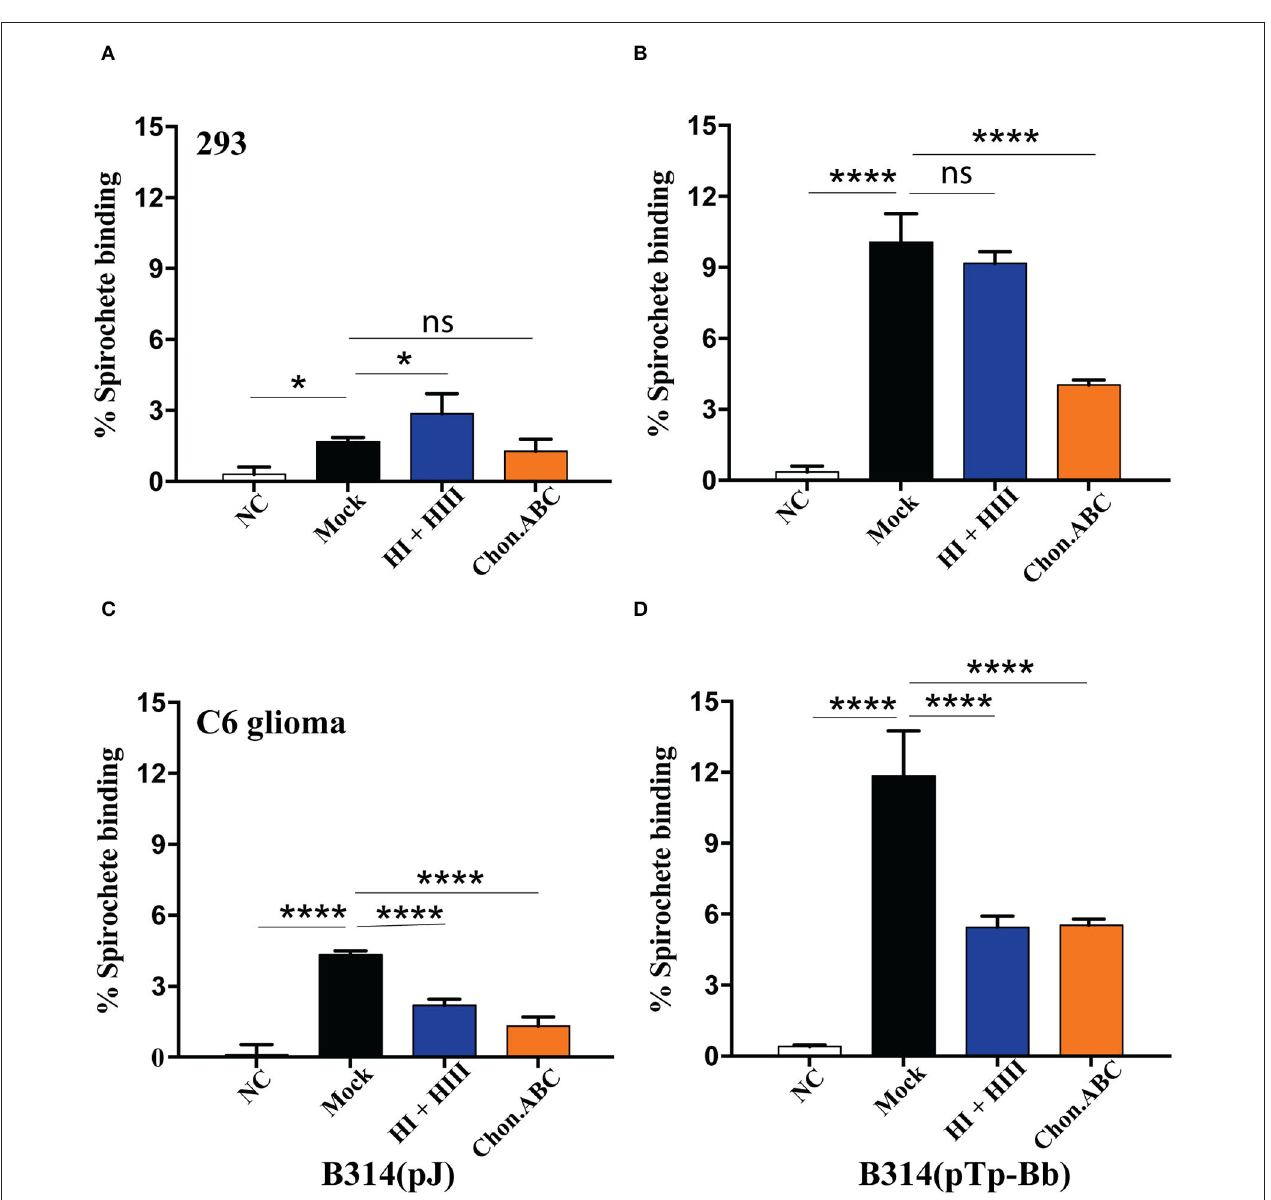
FIGURE 4 | Heparan sulfate and dermatan sulfate as ECM components on specific mammalian cells are required for Tp0954-expressing spirochetes binding. (A,C) Low level binding of B314(V) strain were observed to both 293 and C6 glioma cells and removal of GAGs by specific lyases reduced binding further. (B) Pretreatment of 293 with chondroitinase ABC and not by a combination of heparinase I and III (HI and HIII) inhibited binding of radiolabeled Tp0954-expressing B314 strain, indicating contribution of dermatan sulfate to adherence on these cells, while (D) removal of both heparan sulfate and dermatan sulfate significantly reduced binding of B314(pTp-Bb) to C6 cell line. GAG-lyases are labeled as: NT-No Treatment, Chon-ABC-chondroitinase ABC, and HI + HII-heparinase I + III. Statistically significant difference was determined by unpaired two-tailed t -test with Welch’s correction (* P < 0.05, **** P < 0.0001, ns, not significant).